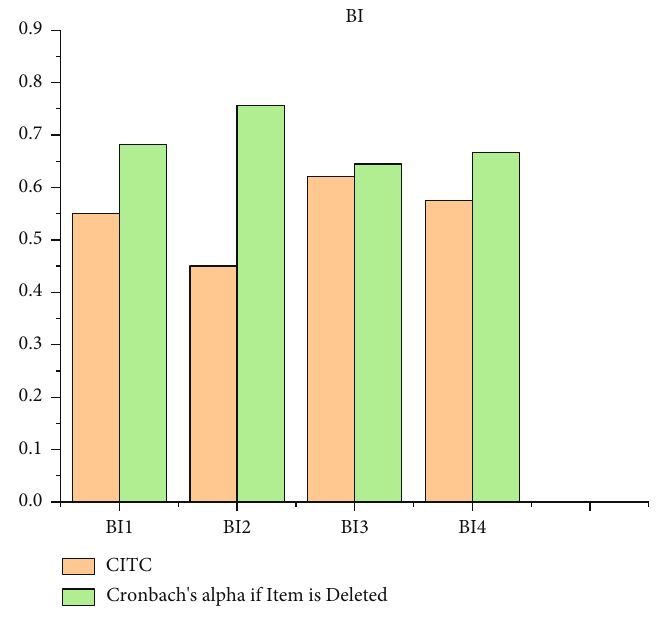
Figure 9: Results of BI analysis. Table 2: Means and standard deviations of study